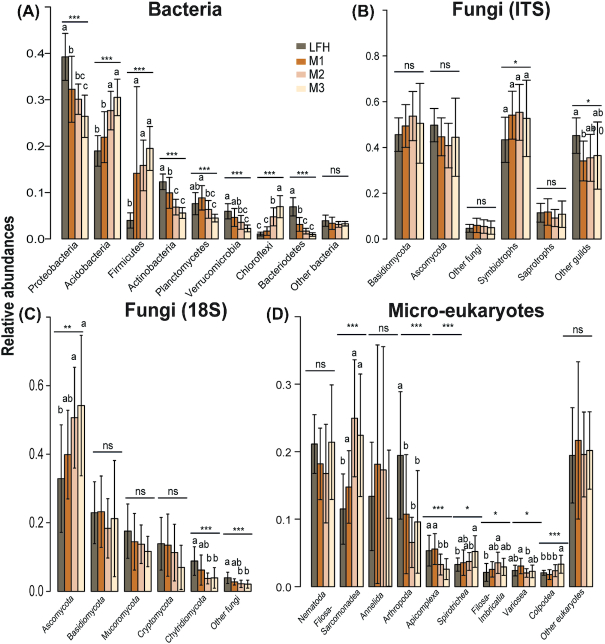
Barplots displaying abundances distribution of the different microbial taxa (phyla). Plots for relative abundances of the bacterial (A), fungal (ITS: B; 18S: C), and micro-eukaryotic (D) taxa with soil depth (forest floor (LFH) and three mineral soil layers: 0–5 cm (M1), 5–15 cm (M2), and 15–30 cm (M3)) are shown here. Statistically significant differences among soil depth was analysed using ANOVA and Tukey´s post-hoc test. Note the significant difference in distribution of fungal groups (Ascomycota) as revealed by the 18S rRNA gene markers (C) but pattern absent while using ITS (B).